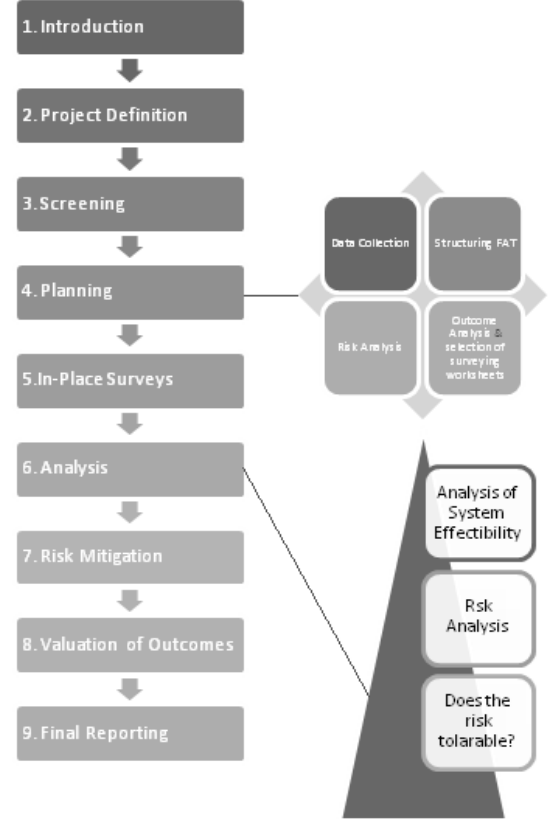
Figure 3. Risk assessment process of dams based on RAM-D method (Jozi, 2001)